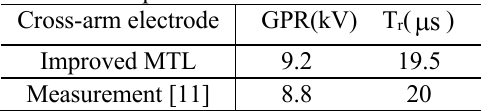
Figure 5: Transient voltage of center-fed four-arm electrode based on the improved MTL and measurement. Table 1: GPR and T r of center-fed four-arm electrode based on improved MTL and measurement.